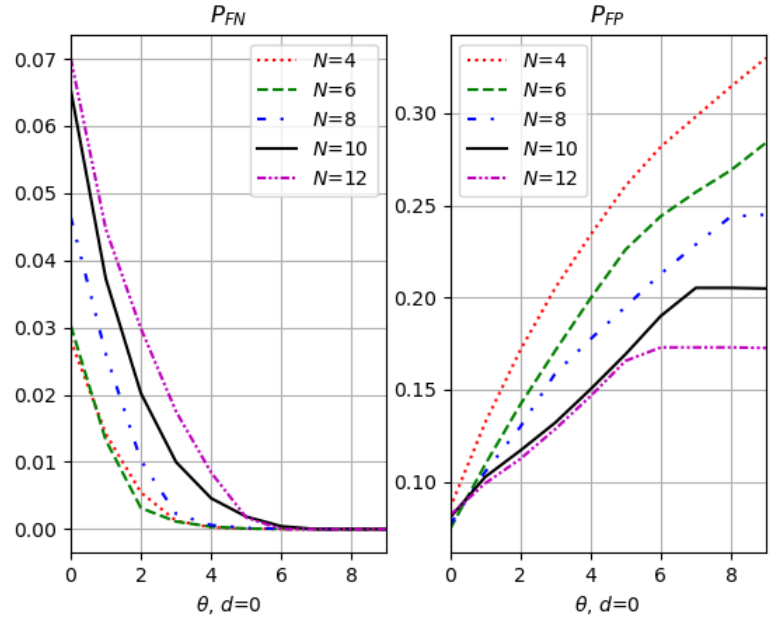
Figure 9. e-HARQ prediction errors: false negative probability and false positive probability from left to right,